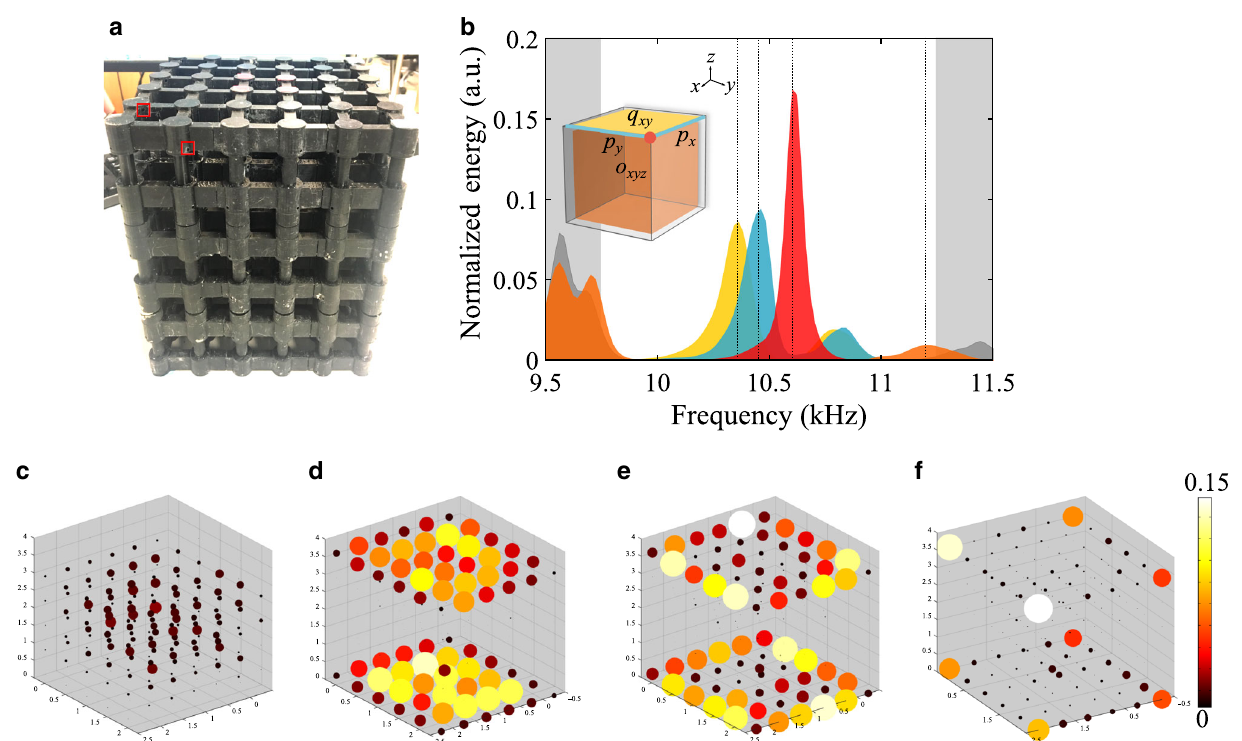
Fig. 3 Experimental demonstration of acoustic octupole TI. a Photograph of the assembled structure consisting of 3 × 3 × 3 unit cells. Location of probe holes is shown by red squares. b Normalized acoustic frequency-response spectra for the selective bulk (orange), surface (yellow), edge (blue) and corner sites (red) of a fi nite structure. Gray-colored spectra represent surface and hinge states in the vertical boundaries perpendicular to the yellow-colored surface. Inset is the schematic of selective groups of resonators, in which their respective topologies are shown, like bulk has octupole moment o xyz , top surface has octupole moment q xy , and top edges have dipole moment p x and p y . c – f The fi eld pro fi les of c bulk states, d surface states, e hinge states and f corner states extracted from the frequency responses of all resonators and chosen at selected frequencies indicated by dashed lines in ( b ).